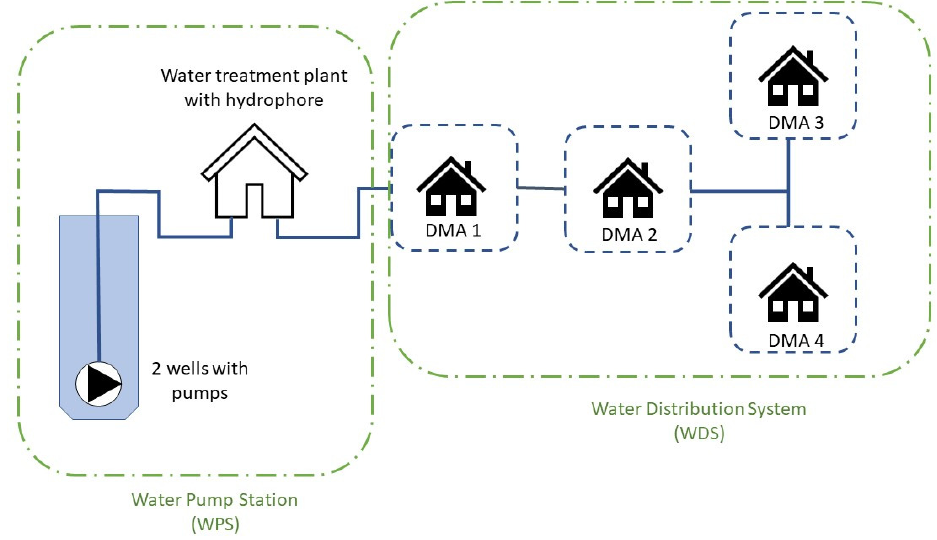
Figure 1. The Water Pump Station (WPS) and the Water Distribution System (WDS) connection diagram.